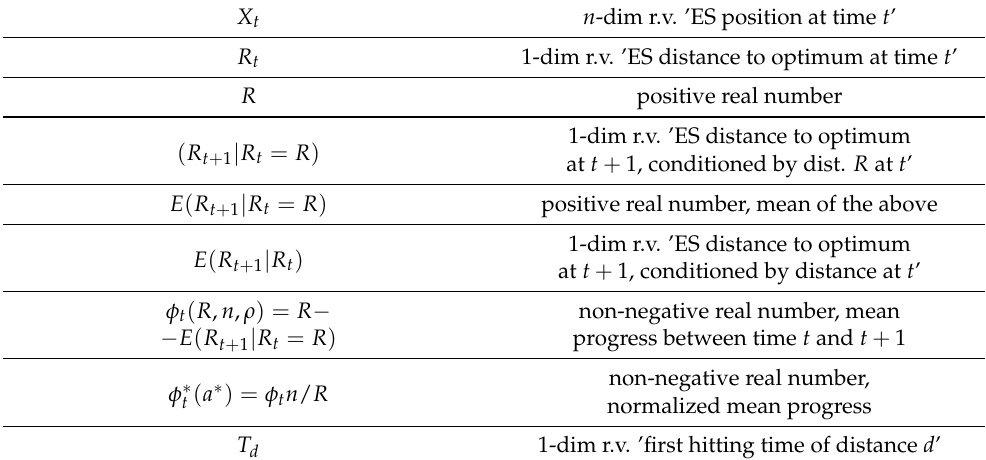
Table 1. Mathematical concepts used in ES analysis. X t n -dim r.v. ’ES position at time t